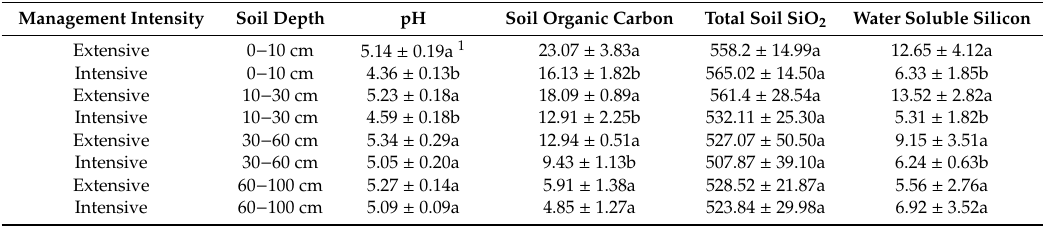
Table 1. Soil pH, soil organic carbon and total soil SiO 2 concentration (means ± standard